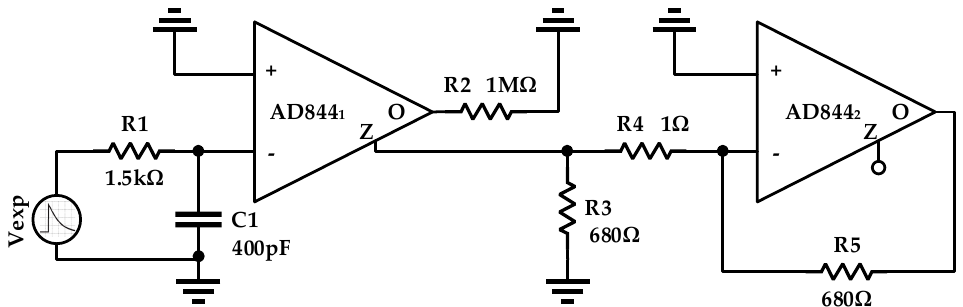
Figure 9. Simplified schematic of the discrete interface.